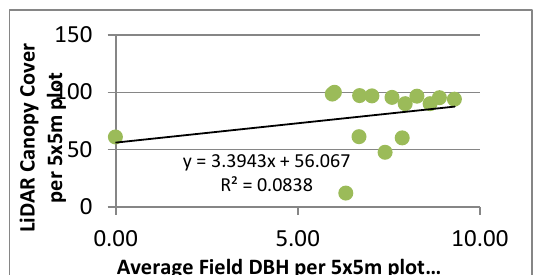
Figure 7. Linear Regression equation of the CC and DBH correlation for the sample plots located at the middle part of the forest.